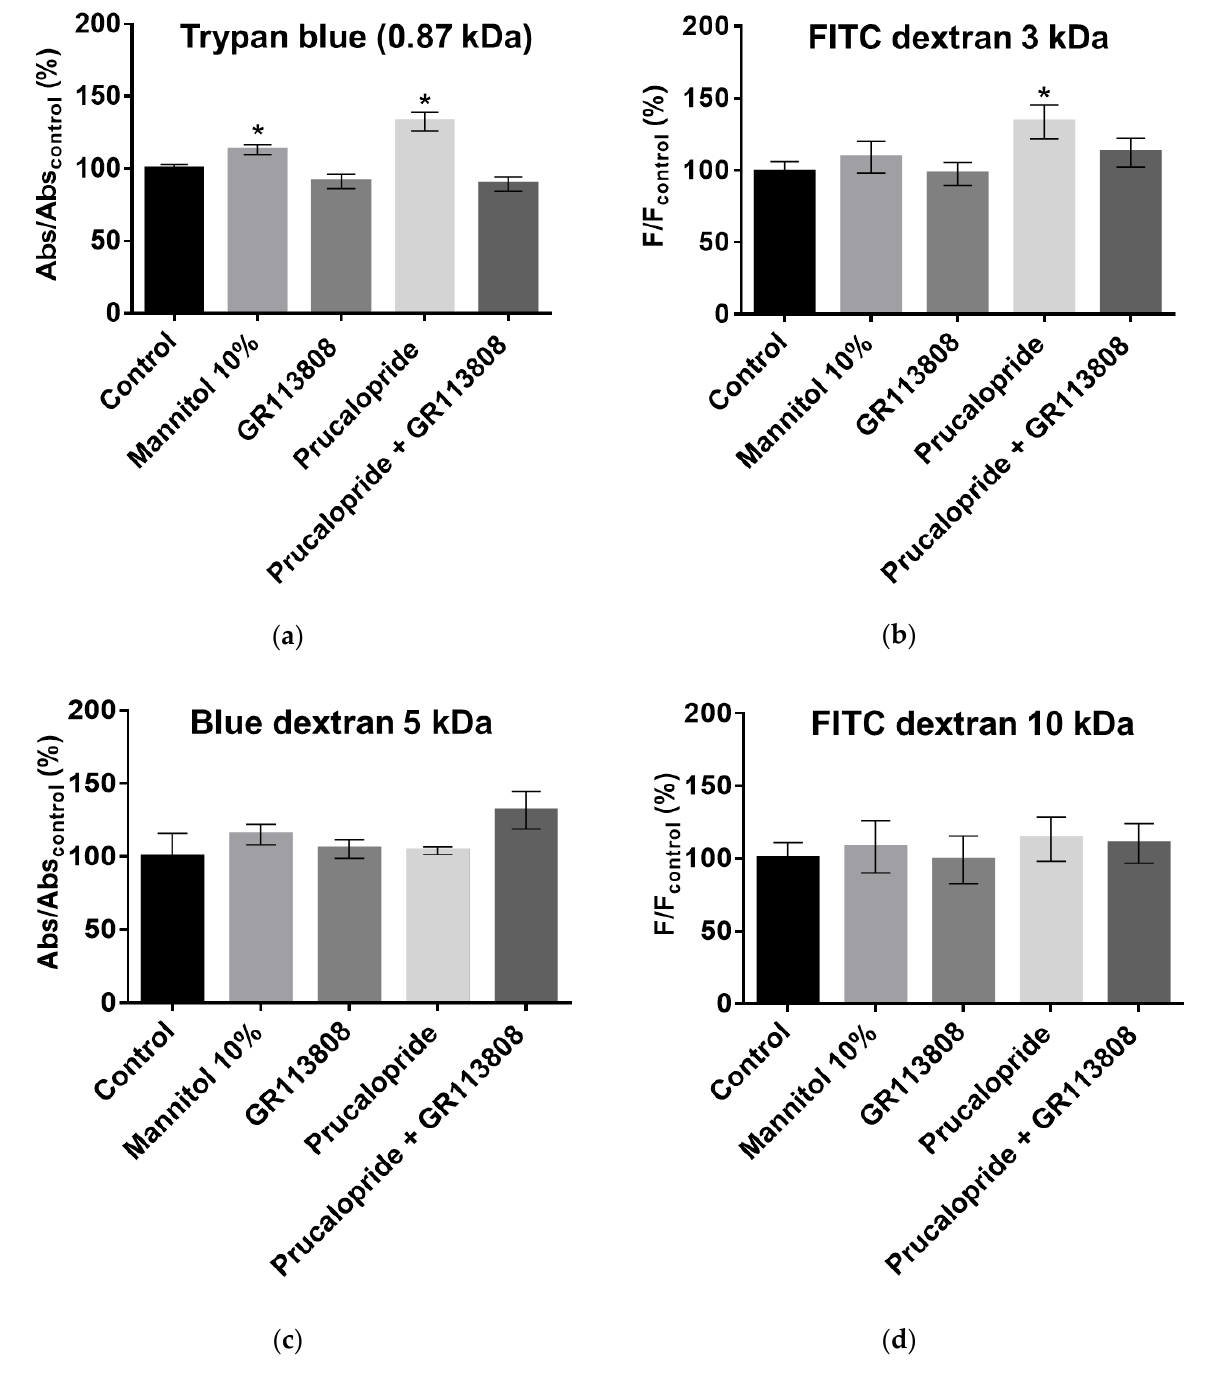
Figure 5. Prucalopride effect on blood–brain barrier permeability in hCMEC/D3 cells. Hypertonic mannitol was used as positive control of blood-brain barrier paracellular permeabilization. Prucalopride stimulation increases the permeability flux of ( a ) Trypan blue and ( b ) FITC dextran 3 (kDa), whereas GR113808 and GR113808 + prucalopride do not change the flux compared to the control. Prucalopride does not change the permeability of ( c ) blue dextran (5 kDa) or ( d ) FITC dextran (10 kDa). Histograms represent mean ± SEM from three independent experiments. * p < 0.05; Abs: measure of absorbance; F: measure of fluorescence.